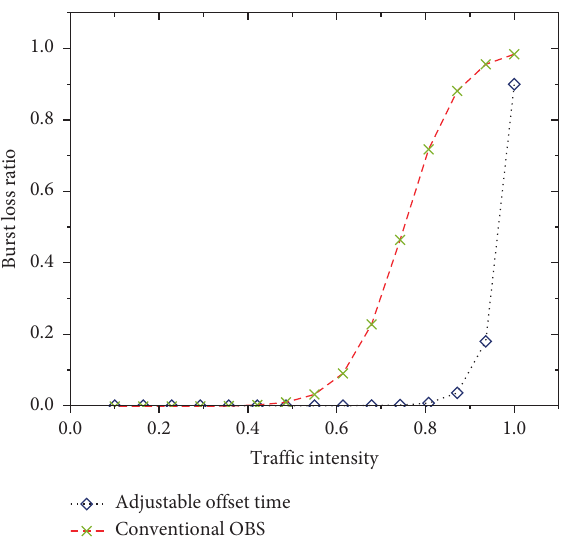
Figure 10: Burst loss ratio due to contentions.